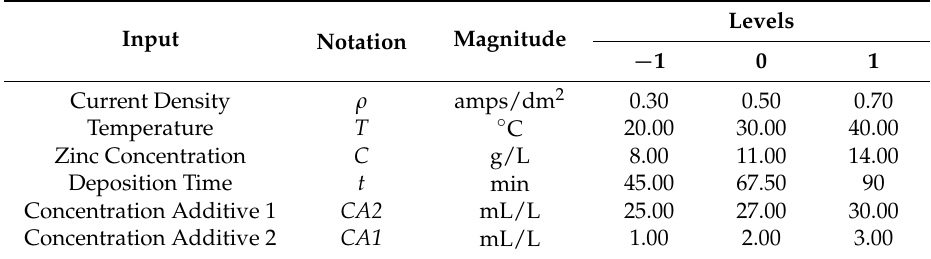
Figure 4. Metallographic analyses of the preliminary zinc coating: ( a ) surface finish of the coating with a very rough surface finish; ( b ) very rough surface with large zinc crystals; ( c ) reduced homogeneous coating formed by small crystals and with a very smooth surface; and ( d ) homogeneous coating formed by small crystals and with a very smooth surface. Table 1. The experimental design levels of the Box-Behnken design (BBD) method and the independent variables.